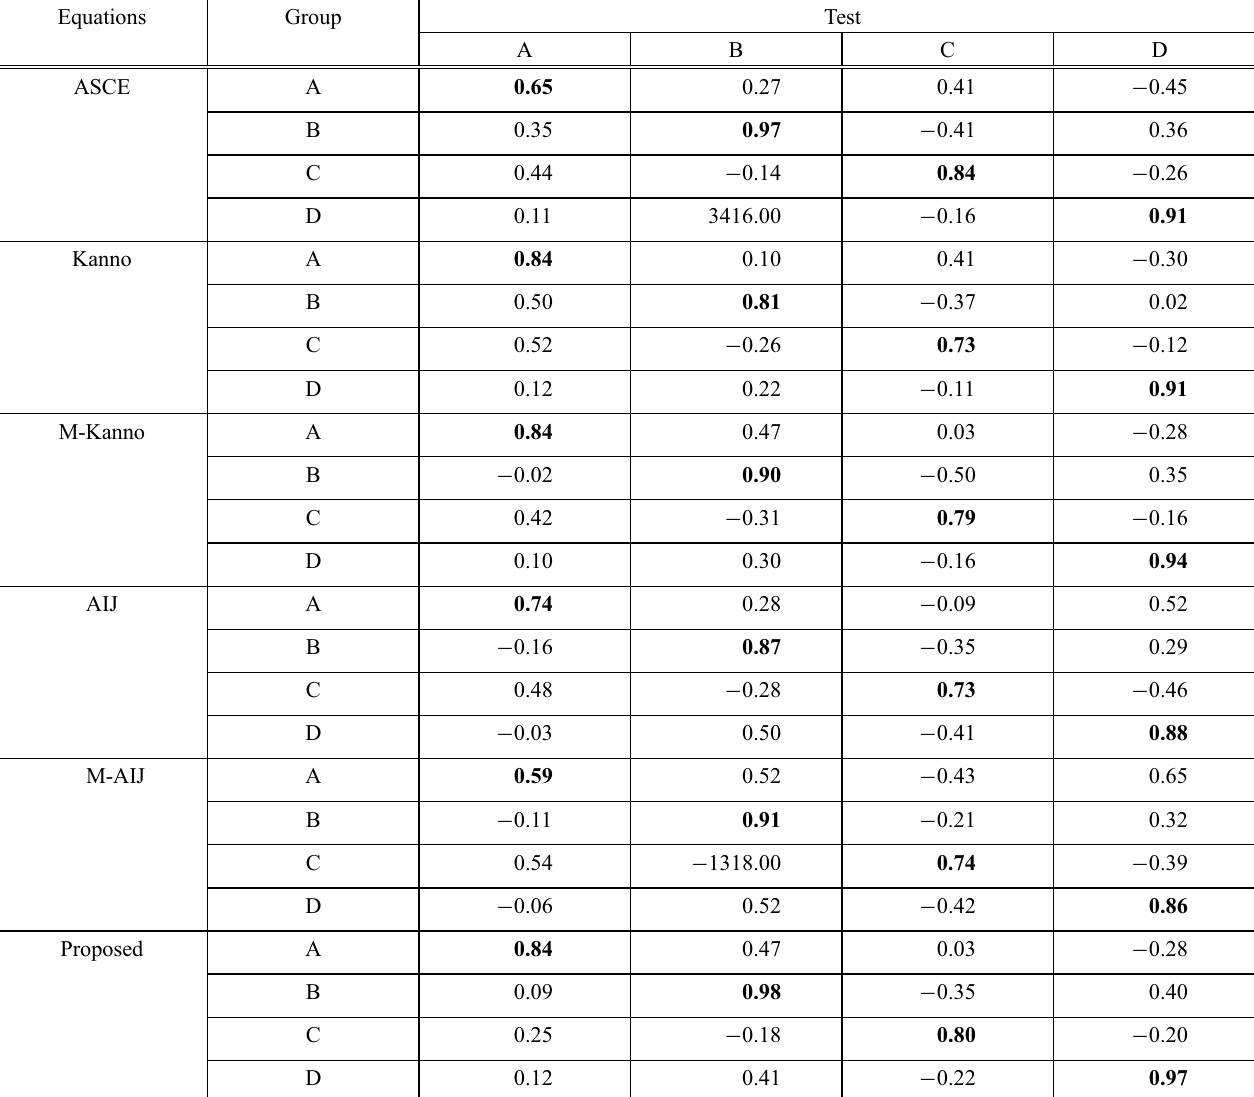
Table 7 Correlation coefficients.